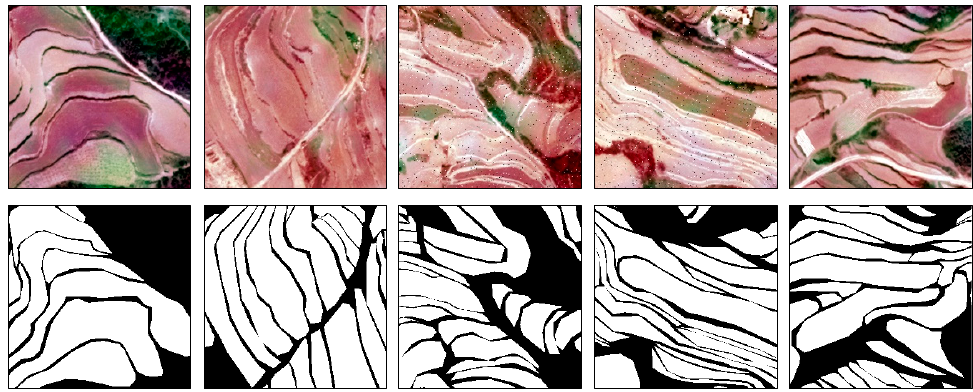
Figure 3. WorldView-1 sample set of fused images and their corresponding labels. The top row shows the WorldView-1 sample set of fused images. The bottom row represents the true labels corresponding to the WorldView-1 sample set of fused images.